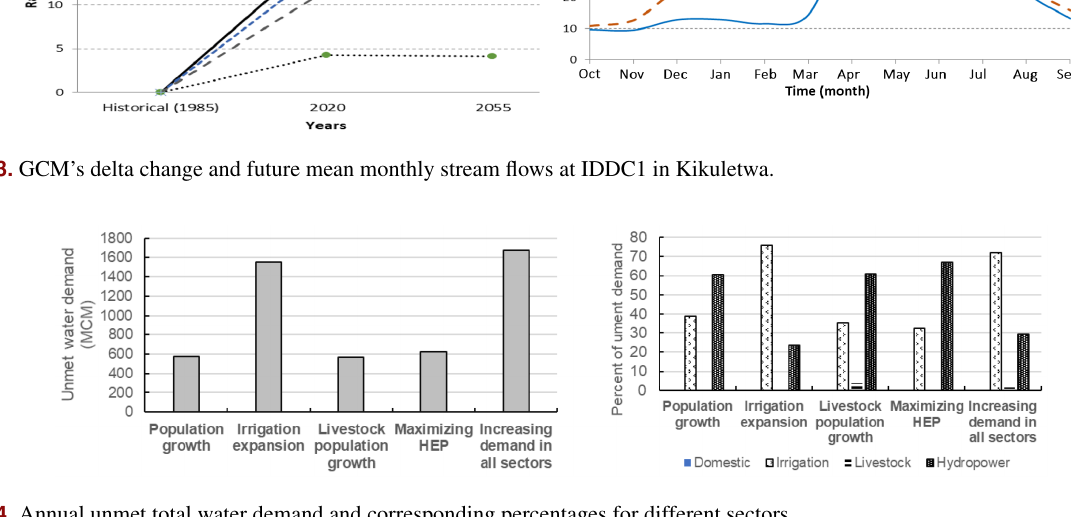
Figure 4. Annual unmet total water demand and corresponding percentages for different sectors.